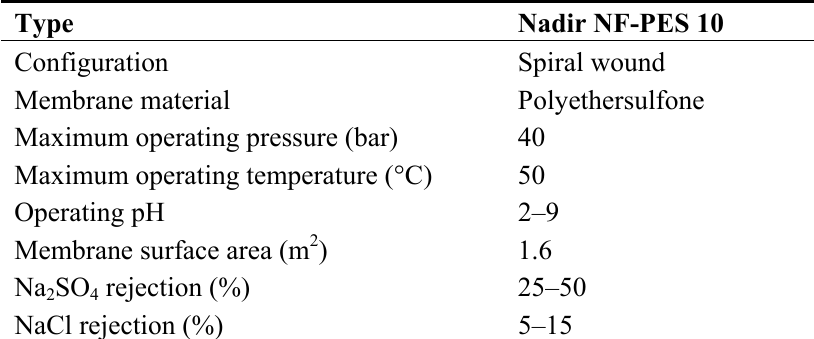
Table 2. Characteristics of the NF membrane